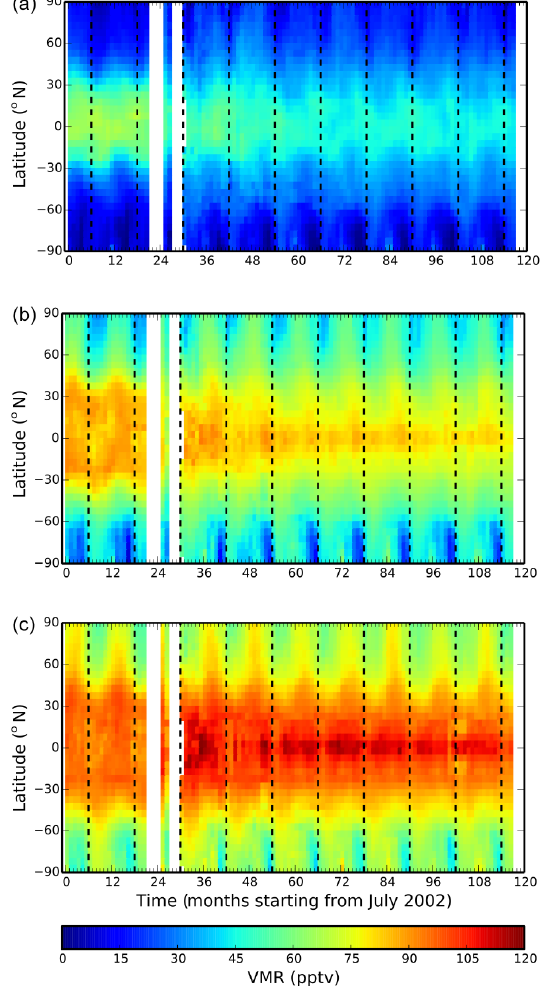
Figure 5. Time evolution of CCl 4 at all latitudes, from July 2002 to April 2012. The three maps refer to different pressure levels: 50hPa (a) , 90hPa (b) , and 130hPa (c) . The vertical dashed lines represent the year boundaries.